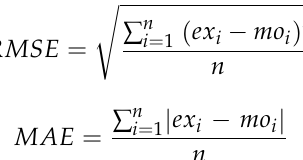
Table 5. Gene expression programming variables detail set.